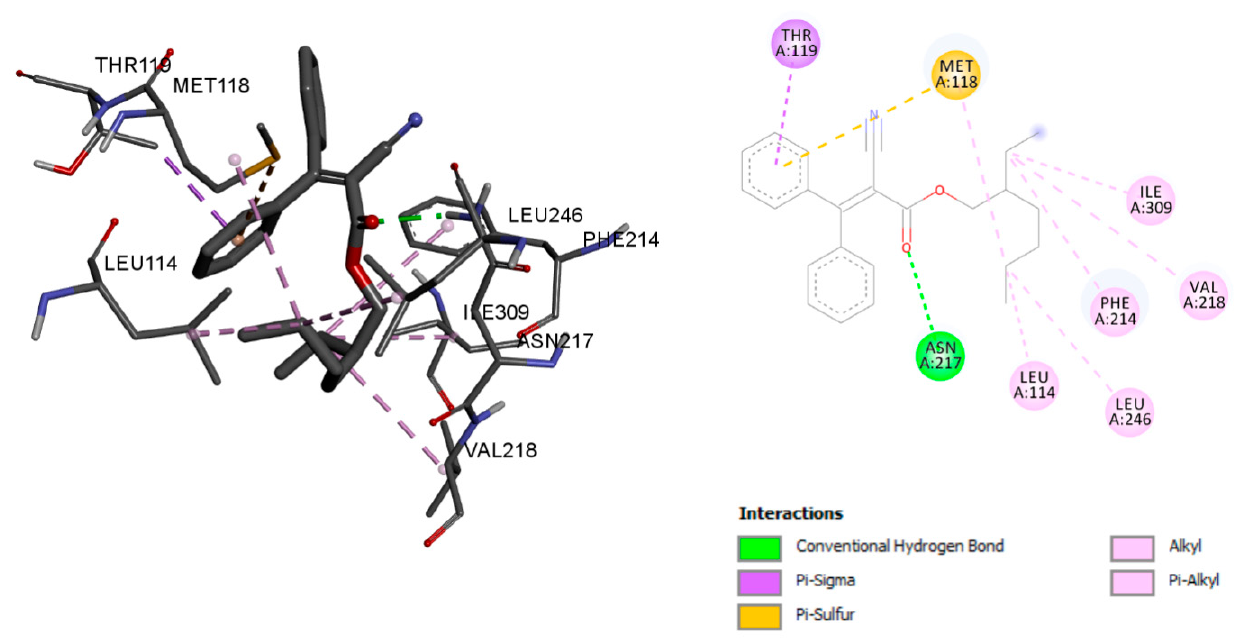
Figure 6. Octocrylene molecular interaction with the enzyme CYP2R1.